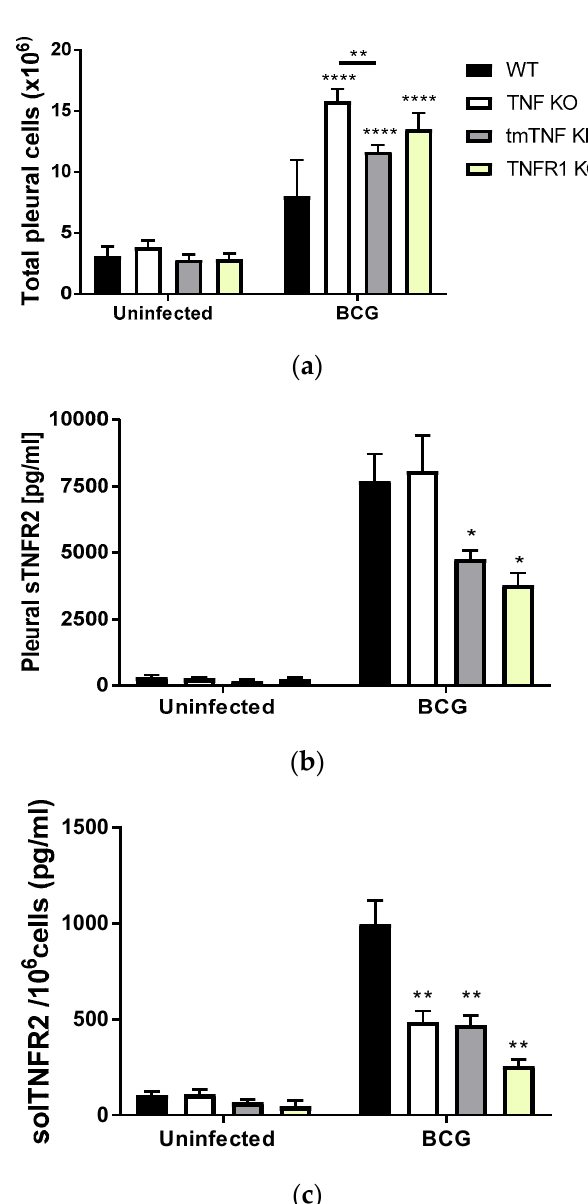
Figure 1. The BCG-induced pleurisy in mice causes the accumulation of pleural cells shedding soluble TNFR2 in the pleural fluid. ( a ) Total number of cells from the pleural cavity recovered from uninfected and from mice infected with BCG for 14 days. Data are represented as bar graphs of means ± SEM from four experiments ( n = 6, uninfected mice and n = 12, infected mice/per group). Comparisons are done between infected WT mice versus infected mutant mice or as indicated in the figure. ** p < 0.01, and **** p < 0.0001 versus WT if not indicated otherwise; ( b ) Concentrations of soluble TNFR2 in the pleural cavity of uninfected mice or in mice infected inside the pleural cavity with BCG at day 14 post-infection. Data are represented as bar graphs of means ± SEM ( n = 4 uninfected mice and n = 12 infected mice/group). Comparisons are between infected WT versus infected mutant mice, * p < 0.05; ( c ) Concentration of soluble TNFR2 reported by million cells from the pleural cavity of uninfected or BCG-infected mice as described in (b). Data are represented as bar graphs of means ± SEM. Comparisons are done between infected WT versus infected mutant mice or as indicated in the figure. ** p < 0.01.